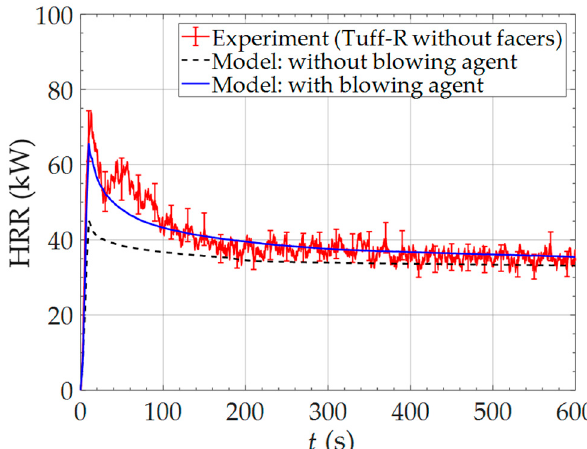
Figure 9. A comparison of the mean experimental heat release rate obtained in the vertical corner flame spread experiments for the Tuff-R panels without facers with the modeling results using pyrolysis models without and with the blowing agent component.